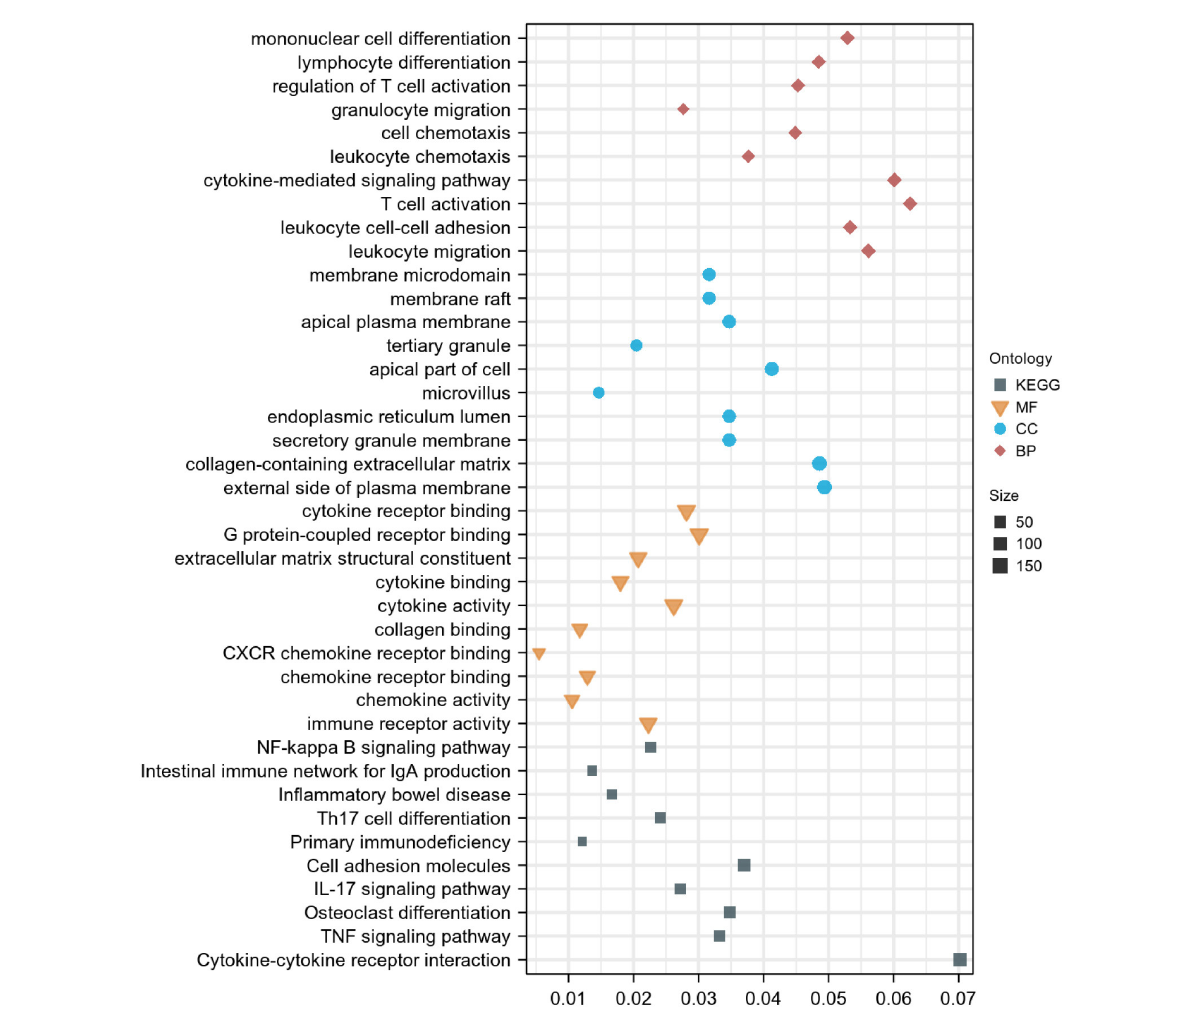
FIGURE3 GO and KEGG enrichment analysis of DEGs. Dot graph of GO and KEGG enrichment analysis, the size of the dot represents the number of enriched genes. The figure shows the terms with p <